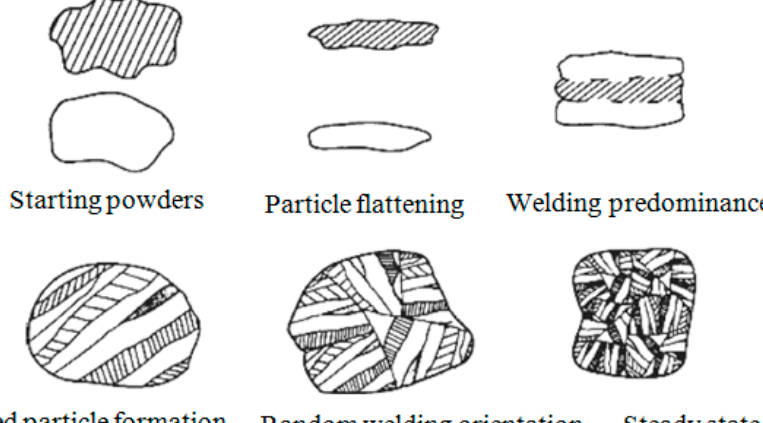
Figure 3. Evolution of various steps of mechanical alloying of a ductile–ductile system [134].